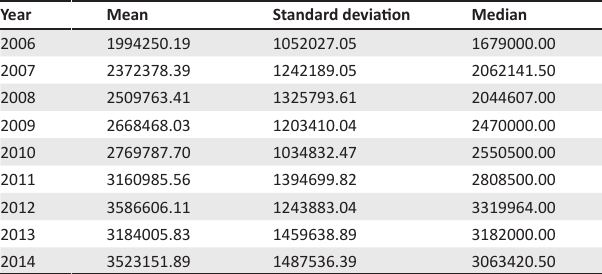
TABLE 3: Chief executive officer fixed pay summary (R’000).